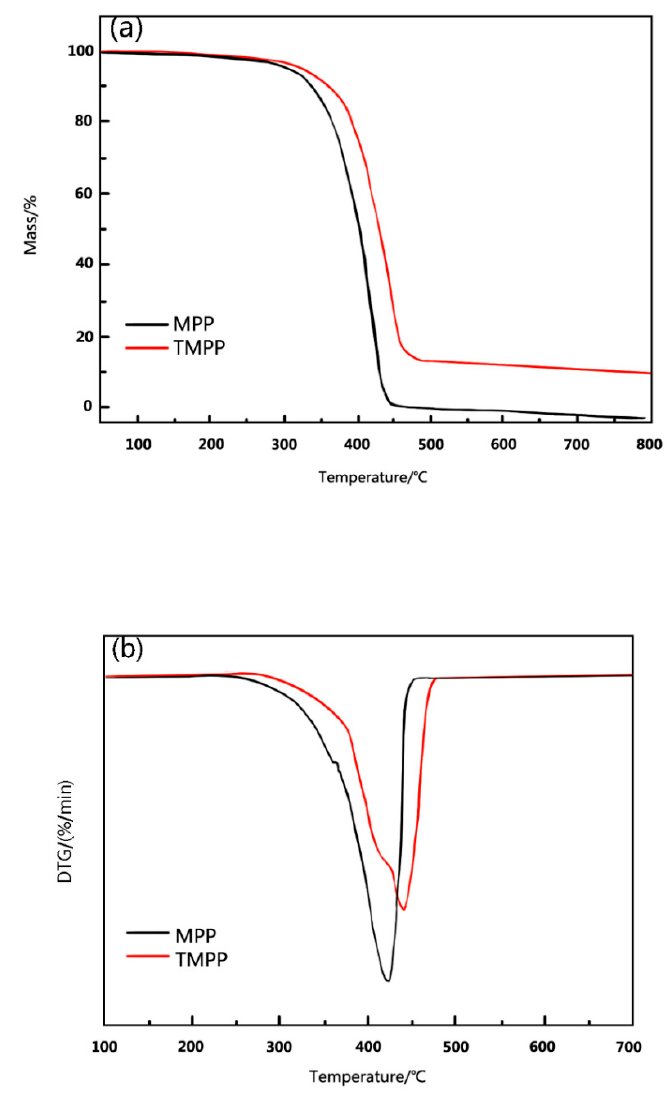
Figure 6. The ( a ) TG and ( b ) DTG curves of MPP and TMPP modifiers.